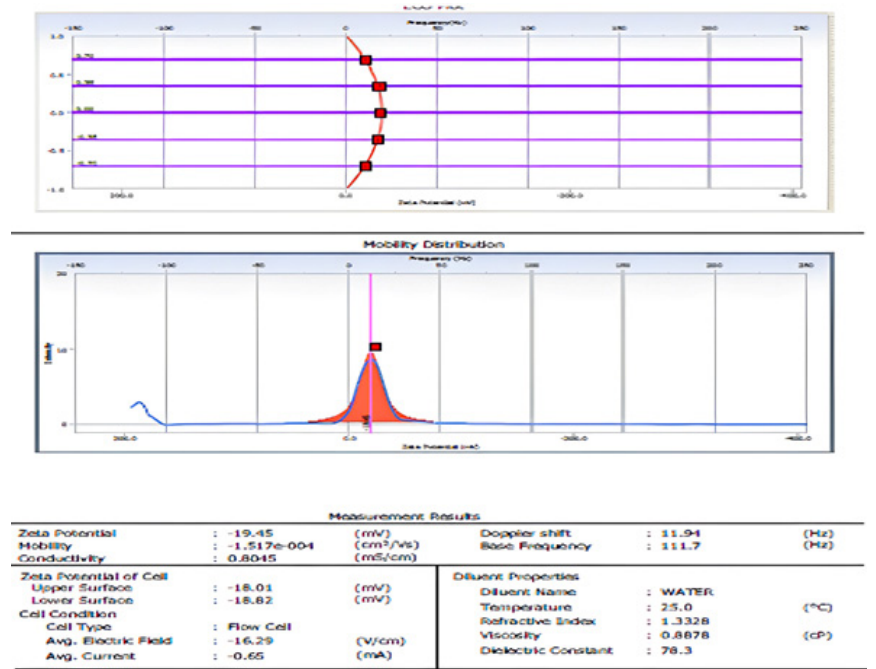
Figure 5. ζ -potential analysis of ZnONP.